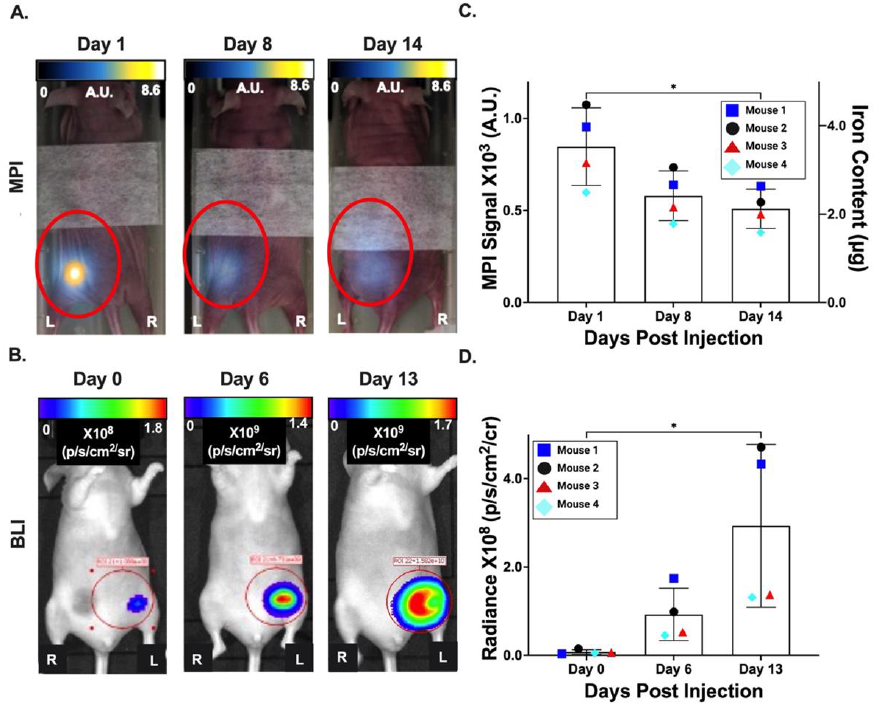
Figure 4. A comparison of BLI (Akaluc) and MPI (Synomag-D) detection of the primary 4T1Br5 breast tumor. ( A ) Representative in vivo MPI scans are shown for days 0, 8 and 14 post MFP injection of labelled cells. ( B ) Representative in vivo BLI scans are shown for days 1, 6 and 13 post MFP injection of labelled cells. MPI and BLI signals were co-registered with bright field images for context. Anatomical left and right are denoted by “L” and “R”. MPI signal is reported in in arbitrary units (A.U.) and enclosed by red circles. BLI signals were displayed as radiance (p/s/cm 2 /sr). ( C ) The MPI signal (left axis) and corresponding iron mass (right axis) were measured from MPI images and are reported for 4 mice. ( D ) Average BLI signal from the primary tumor was plotted for these same 4 mice. * p <